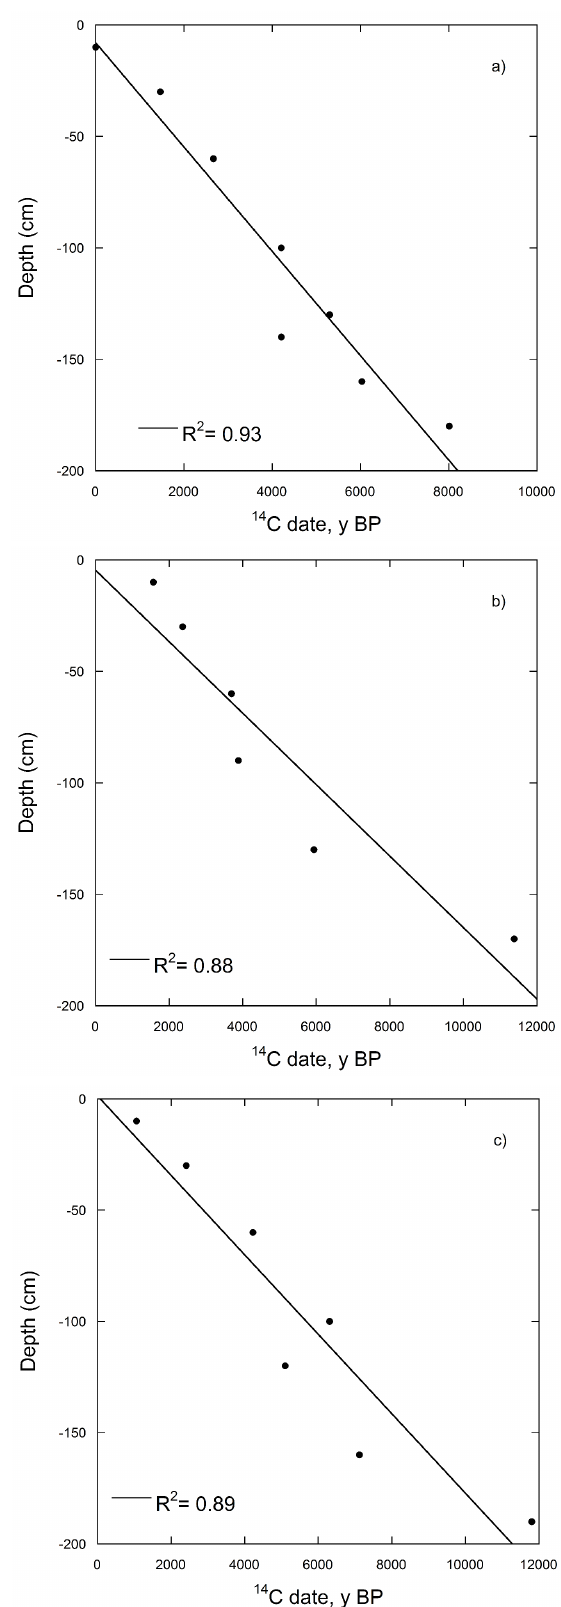
Figure 2. Radiocarbon ages ( 14 C, y BP) of soil (treated for carbonates) at various depths and different sites: ( a ) native, ( b ) fallow, and ( c )